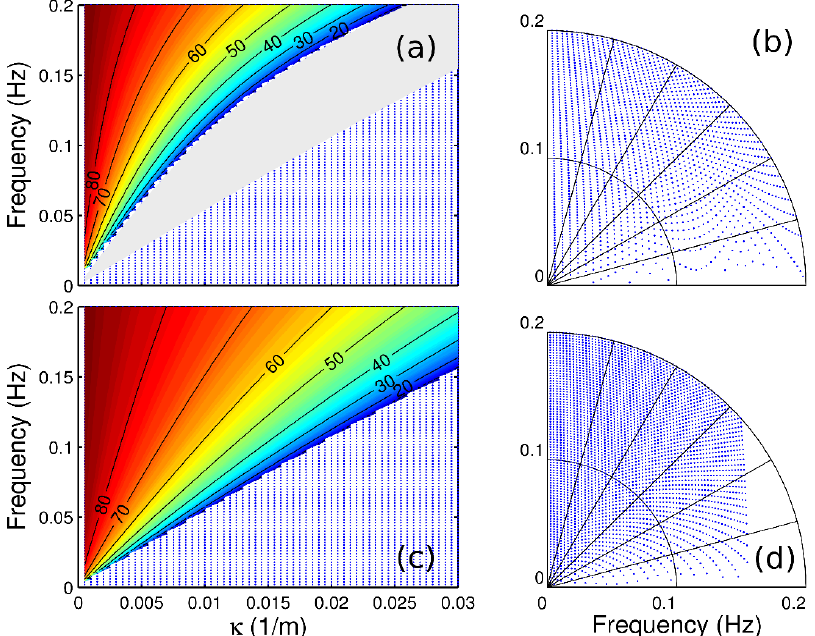
Figure 4. Directional characteristics of the frequency-alongshore wave number (f,κ) representation in comparison with the standard (deep-water) frequency-angle (f,θ) representation, in 15 m water depth (upper panels) and in 3 m water depth (lower panels). ( a , c ) The (f,κ) representation; contours show the corresponding angles of propagation with respect to shore-parallel. The shaded area in ( a ) marks trapped-wave modes ( i.e. , modes that have the turning point between 15 m and 3 m water depth). The nodes of the (f,κ) grid are marked by blue